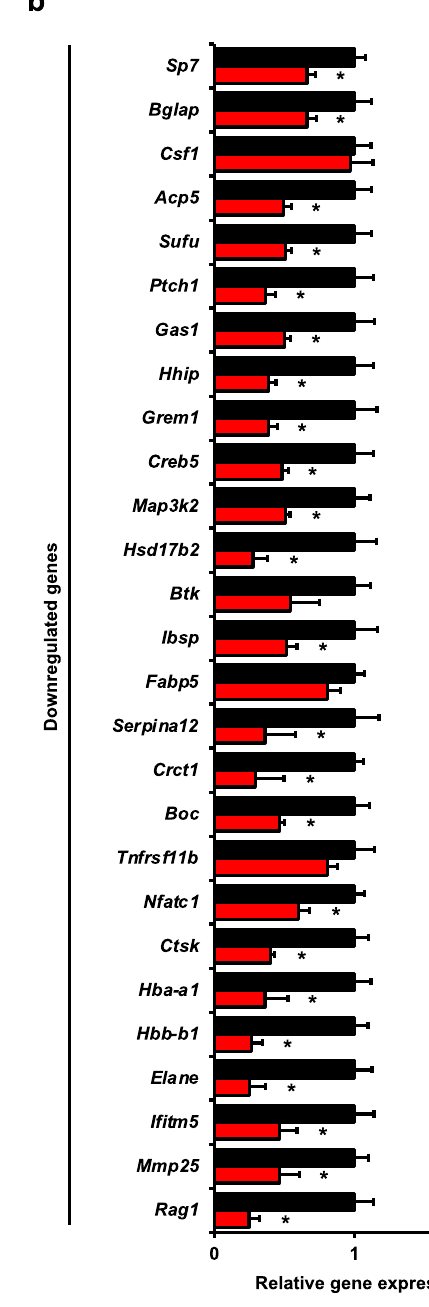
Figure 3. RNA-seq results were validated by qPCR analysis. ( a ) Upregulated and ( b ) Downregulated candidate genes in FcγRIIB -/- mice ( n = 6) compared to WT controls ( n = 6). Data are mean ± SEM. * p < 0.05 compared to WT